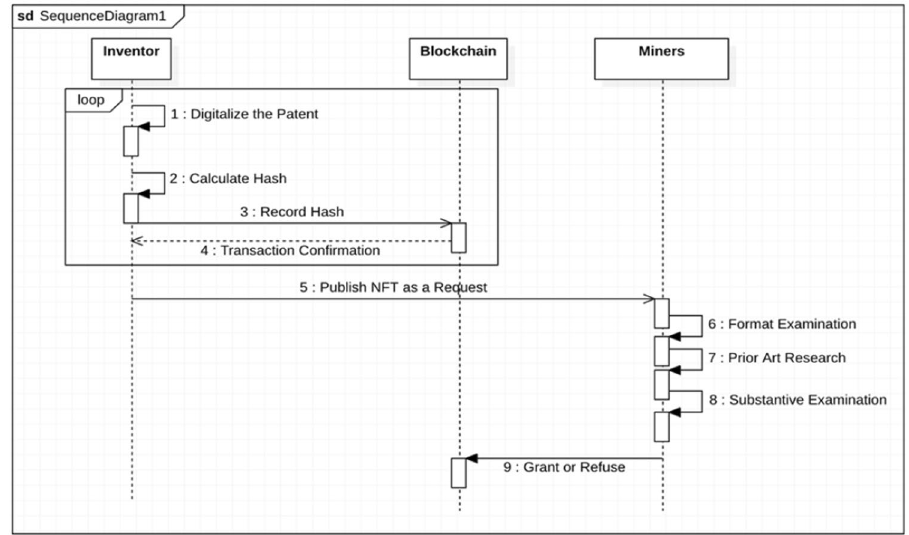
Figure 4. Verification layer sequence